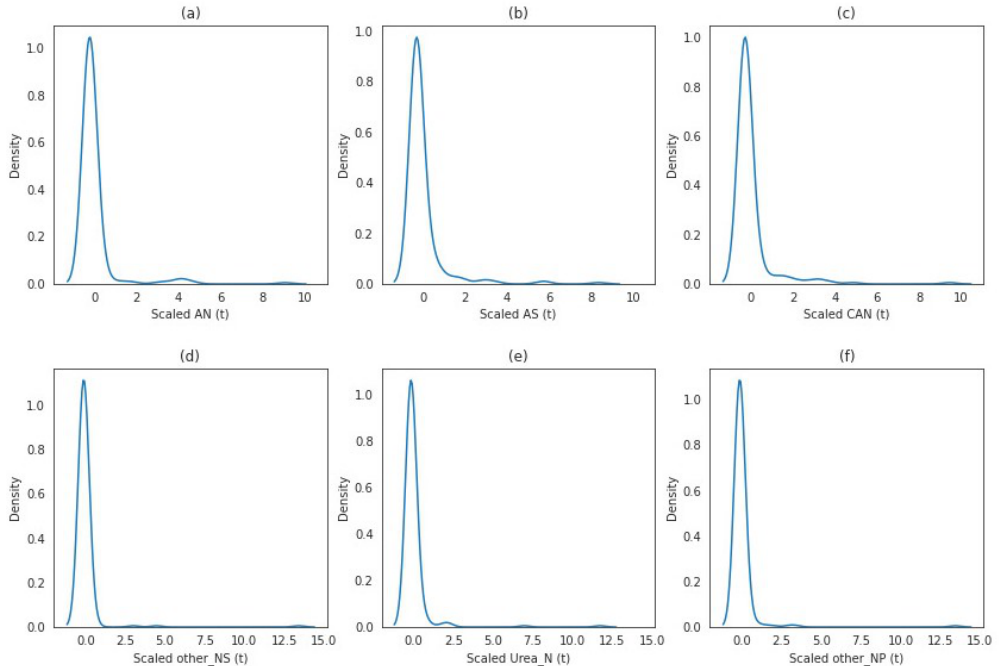
Figure 4. Density plots of selected nitrogen fertilizer consumption per tonne (t) per country: ( a ) den- sity plot of ammonium nitrate (AN), ( b ) density plot of ammonium sulfate (AS), ( c ) density plot of calcium ammonium nitrate (CAN), ( d ) density plot of other NS, ( e ) density plot of urea, ( f ) density plot of other